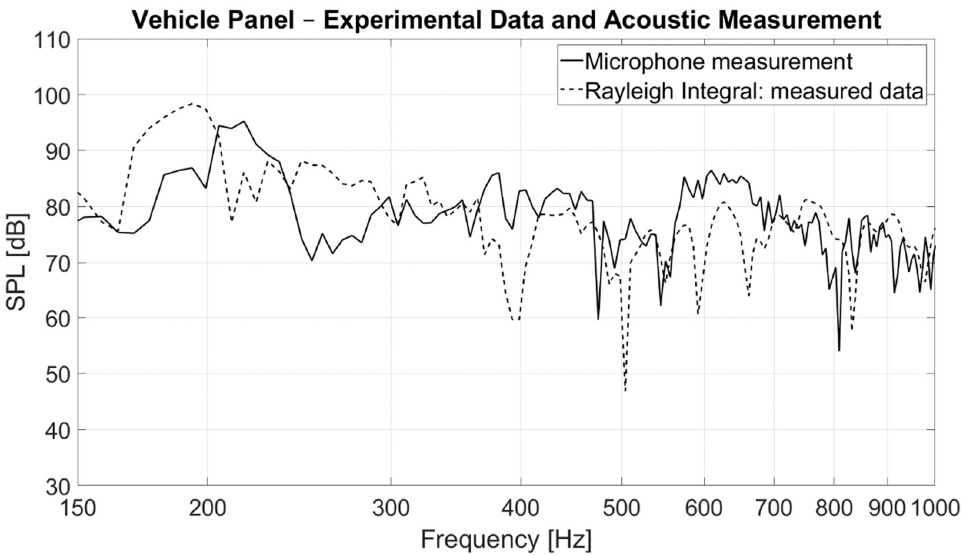
Figure 11. SPL recorded by a microphone (solid line) superimposed with SPL calculated by Rayleigh’s integral (dash line) from real panel measurements at McLaren Automotive.